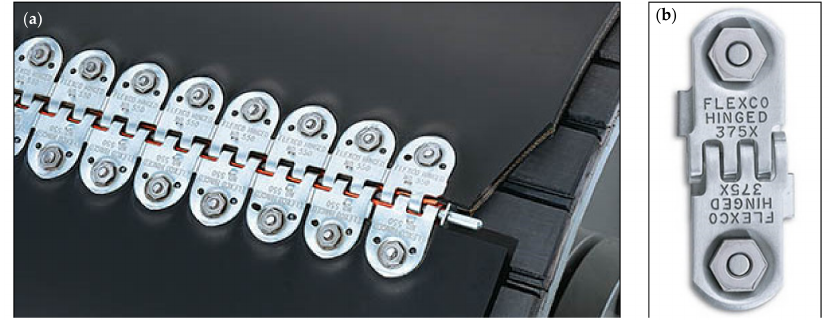
Figure 14. Bolt fastening: ( a ) general view, ( b ) single fastener [25]. Table 6. Hinge pin types with regard to the application [25].